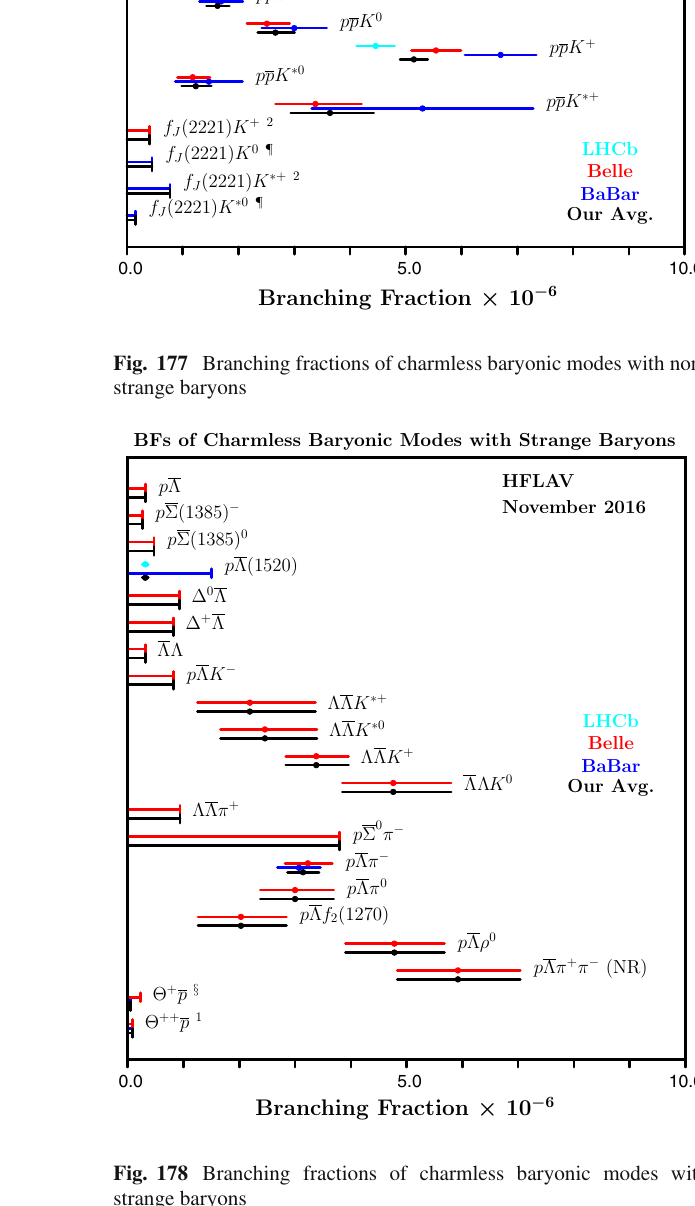
Fig. 178 Branching fractions of charmless baryonic modes with strange